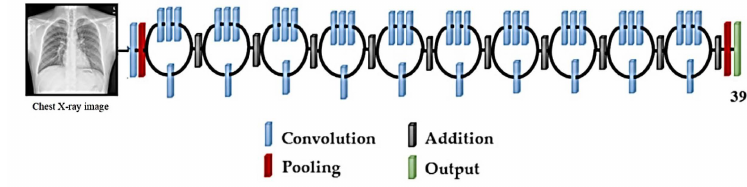
Figure 5. Schematic illustration of the ResNet50 architecture.